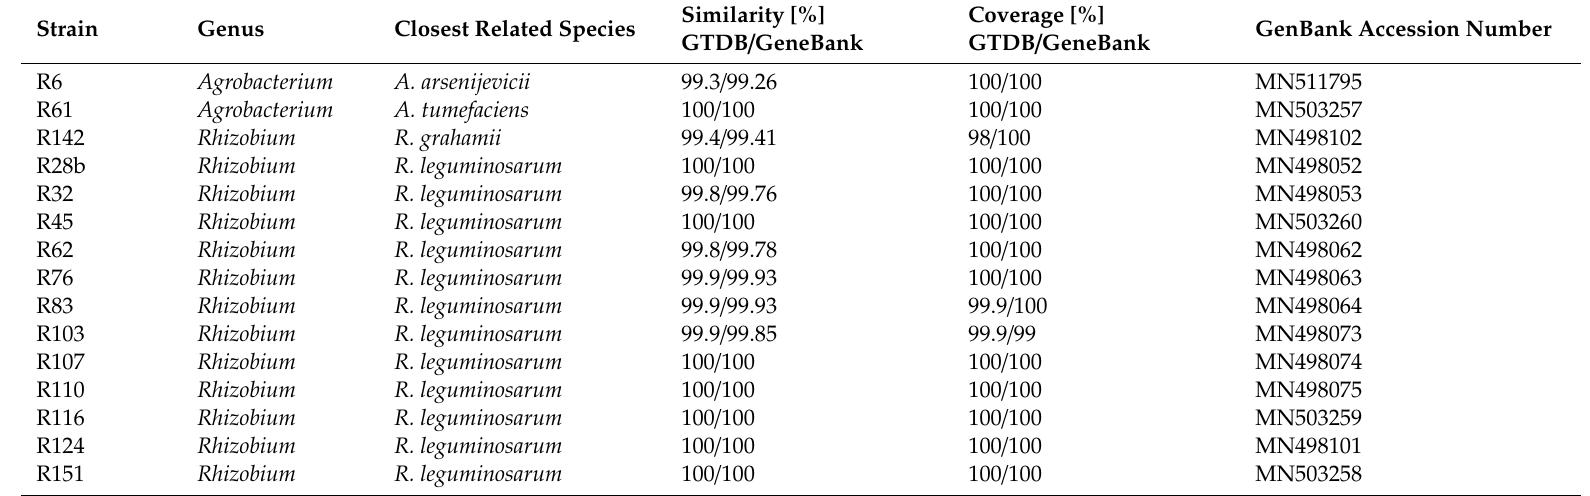
Table 1. Phylogenetic analysis of 16S rRNA sequences of selected